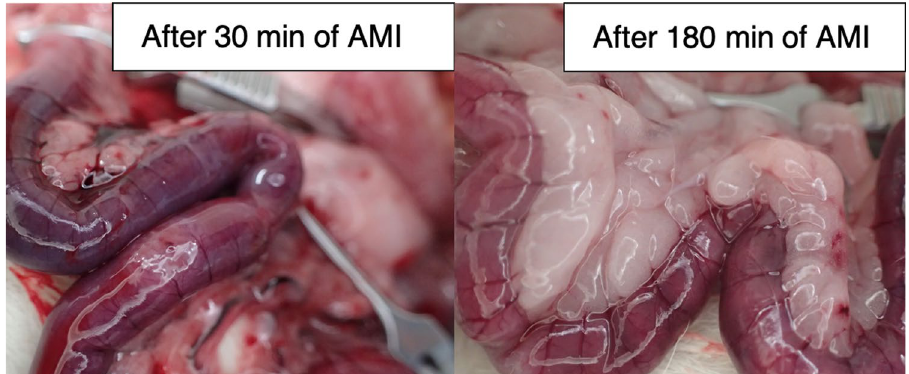
Figure 2. Gross appearance of ischemic ileum in the mild and severe groups. In some cases, the severity of AMI is indistinguishable by the gross appearance alone. PAI is evaluated in the middle of the ischemic region by attaching the transducer on the proximal wall, and five adjacent regions of interest are set in the cross-sectional image (for example, see Fig. 5B). Note: AMI, acute mesenteric ischemia; PAI, photoacoustic